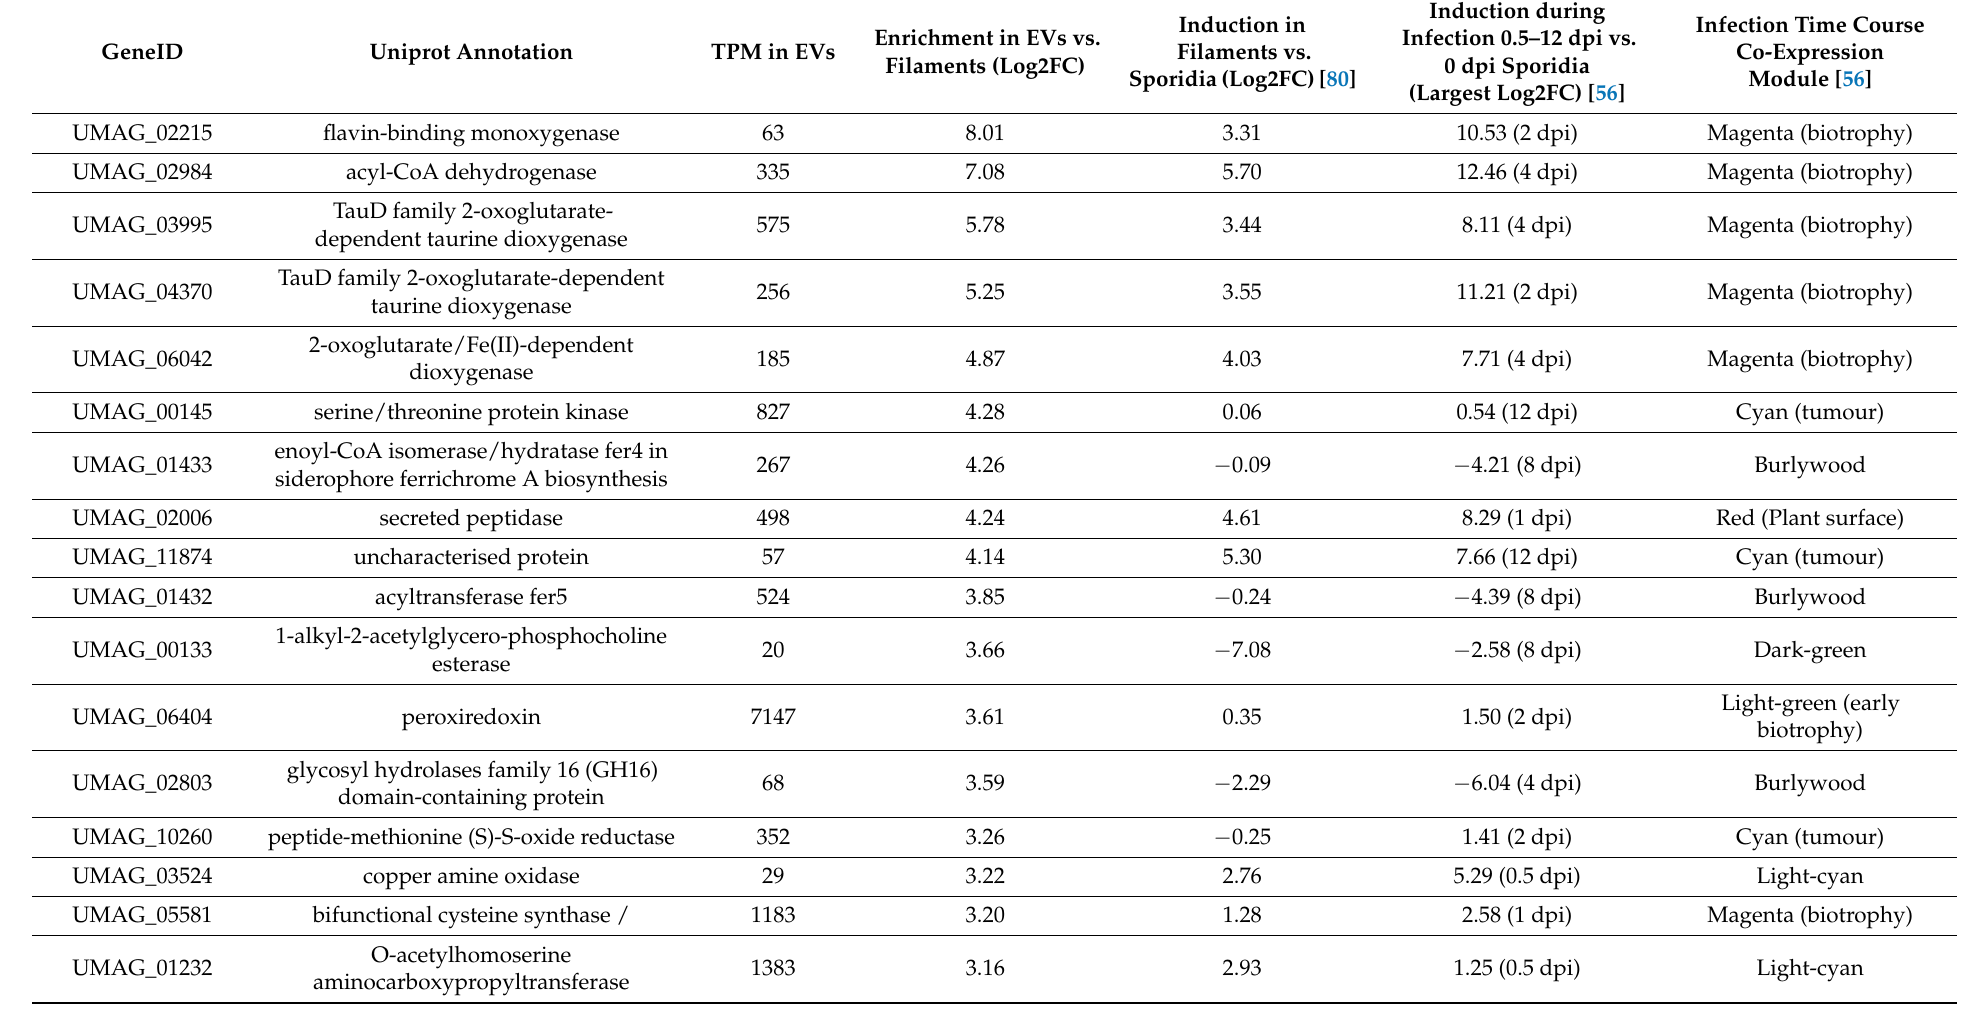
Table 1. mRNAs most highly enriched in EVs of induced filaments (Log2 fold change ≥ 3, padj < 0.01, baseMean ≥ 10). The 5th column from the left contains values obtained by analysing the raw data from Olgeiser et al. [80]. The 6th and 7th columns contain values from the supplementary dataset published by Lanver et al.